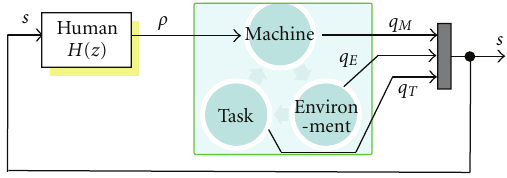
Figure 2: System architecture of human-machine